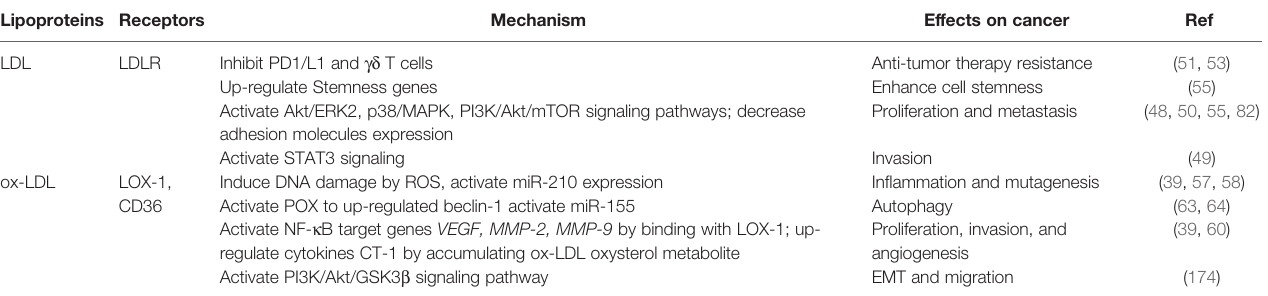
TABLE 3 | Summary of the role of LDL and ox- LDL in cancer progression. Lipoproteins